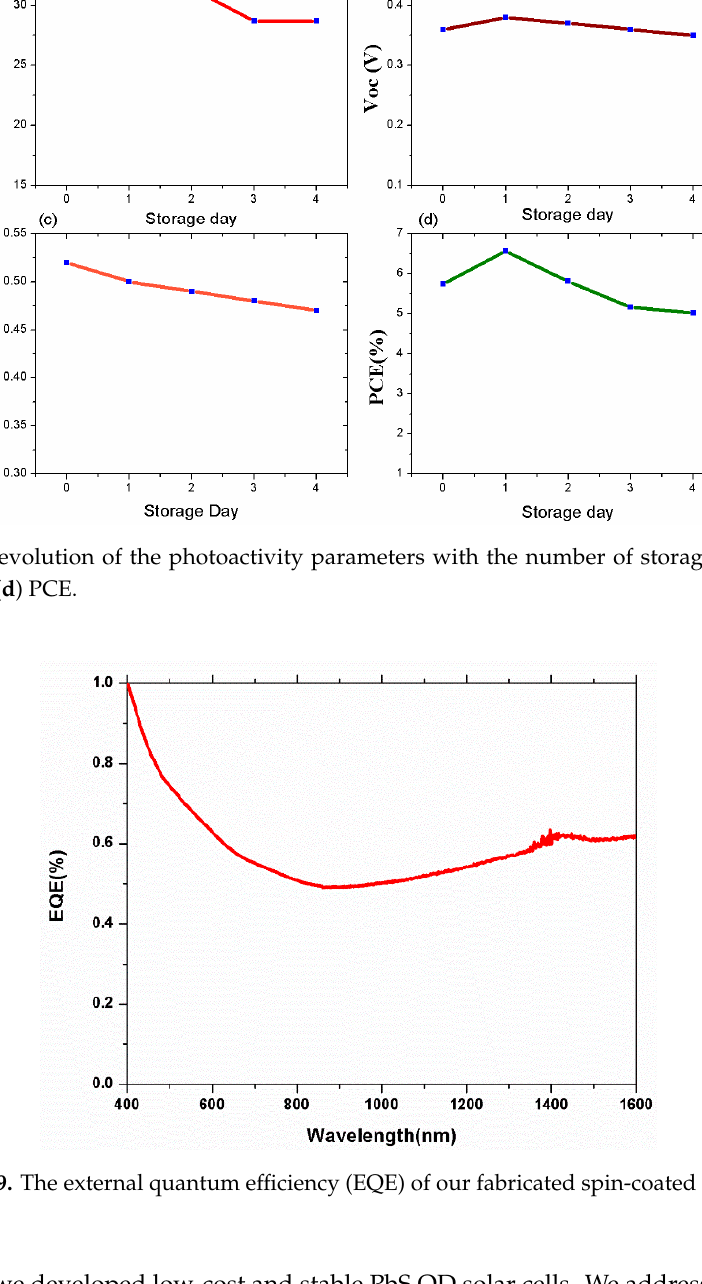
Figure 9. The external quantum efficiency (EQE) of our fabricated spin-coated device.